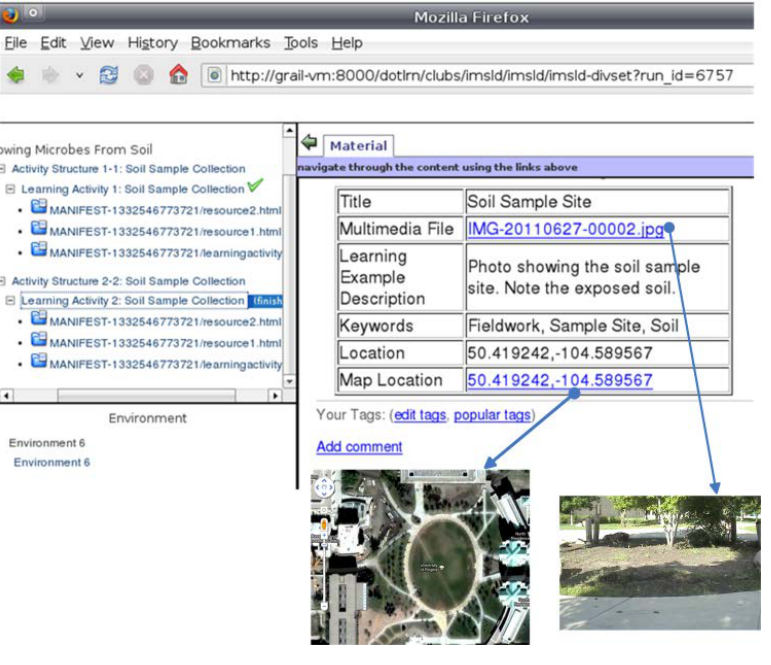
Figure 6 . A MAAIMS authored learning design in an LMS. An authentic learning example and the location it was captured are accessible via